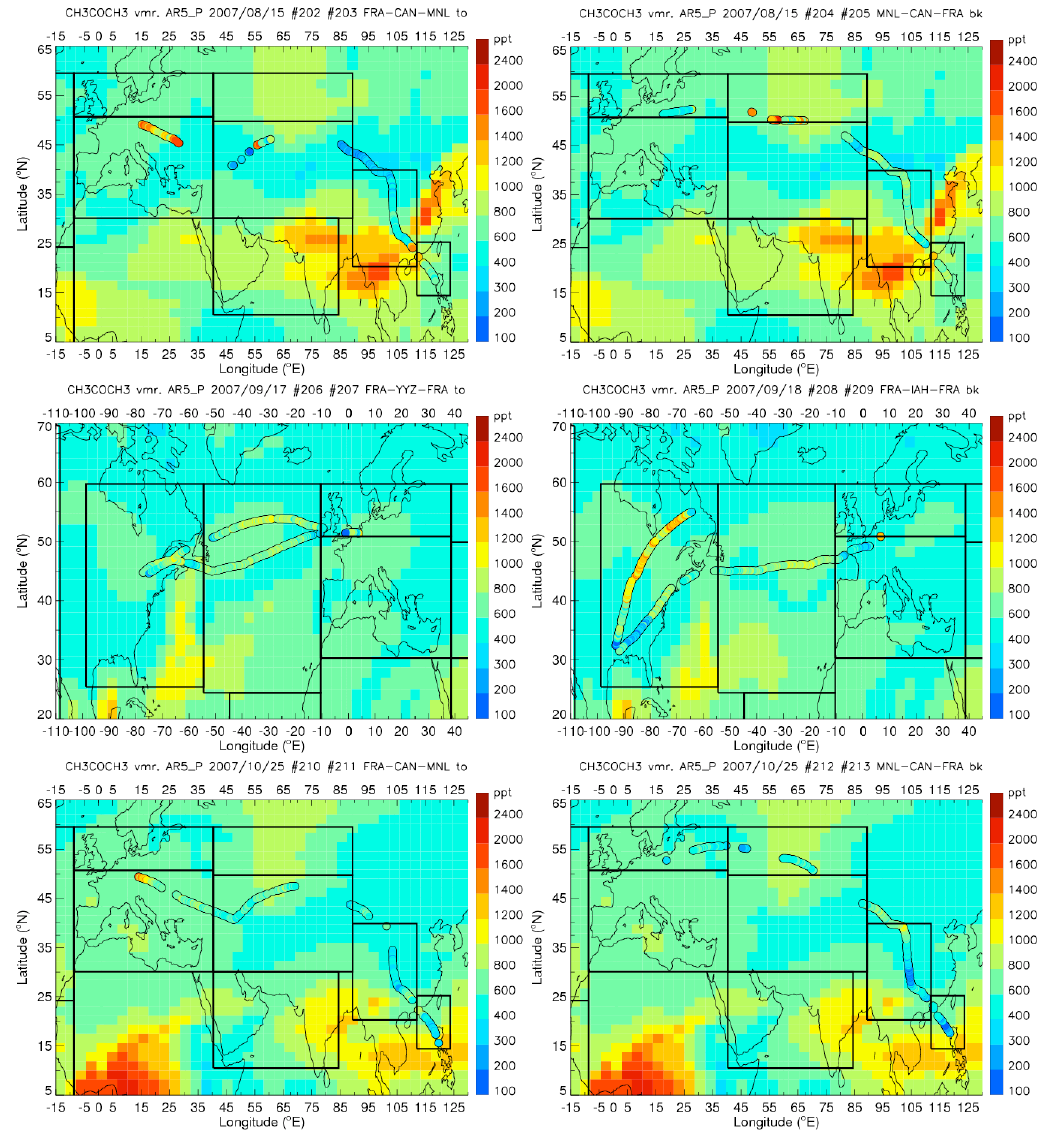
Figure 2. Acetone vmr (pptv) acquired onboard the passenger aircraft along the flight track Fig. 2. for several flights, superimposed on maps of daily averaged simulated acetone vmr at 238 hPa